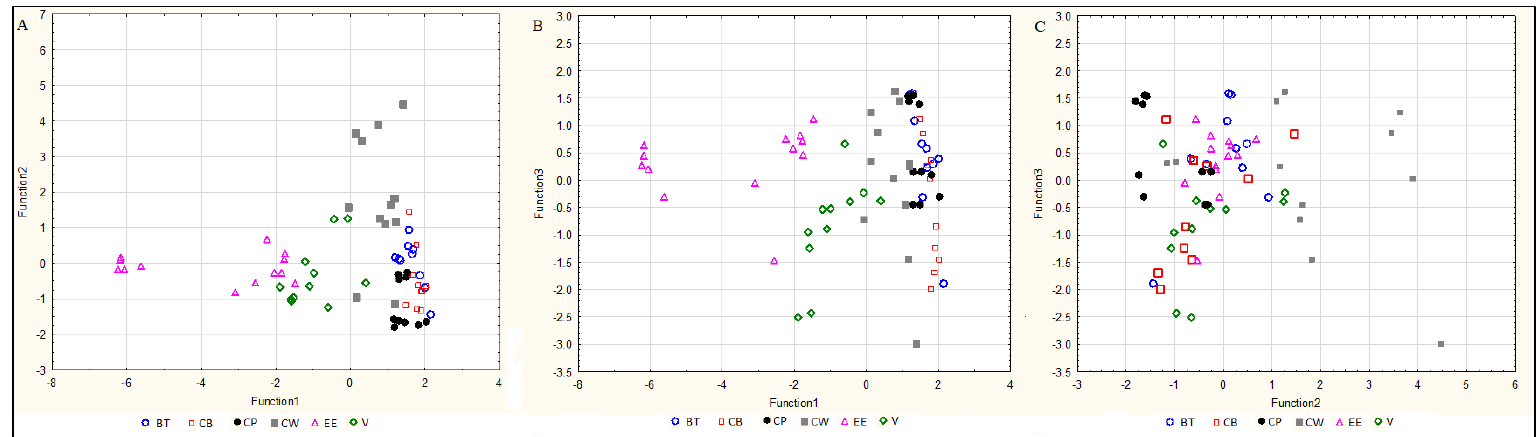
Figure 5. Discriminant analysis of raw freshwater fish. CB—common bream, CP—common perch, CW—common whitefish, EE—European eel, PP—pike-perch, V—vendace. ( A ). Function 1 vs. function 2, ( B ). Function 1 vs. function 3, ( C ). Function 2 vs. function 3.